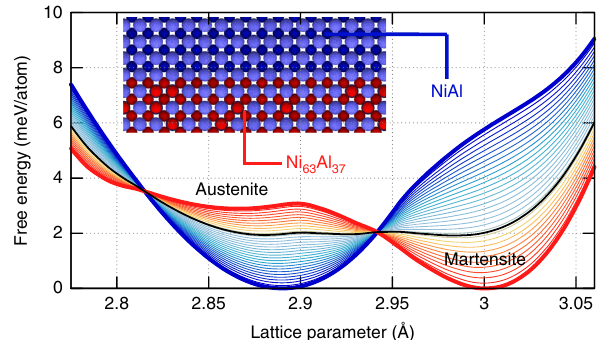
Fig. 1 Free energy landscape engineering in NiAl. Free energy as a function of in-plane lattice parameter from MD simulations of bulk Ni 63 Al 37 and NiAl, interpolated with rule of mixtures. The combination of 65 at% Ni 63 Al 37 (thick red) and 35 at% NiAl (thick blue) is highlighted in black to show the possibility of ultra-low stiffness. The martensite and austenite are labeled for Ni 63 Al 37 . The inset shows a schematic of the epitaxial interface between NiAl and Ni 63 Al 37 where Al atoms are light blue, Ni in NiAl is dark blue, and Ni in Ni 63 Al 37 is red. Note that this atomic coloring is unique to this fi